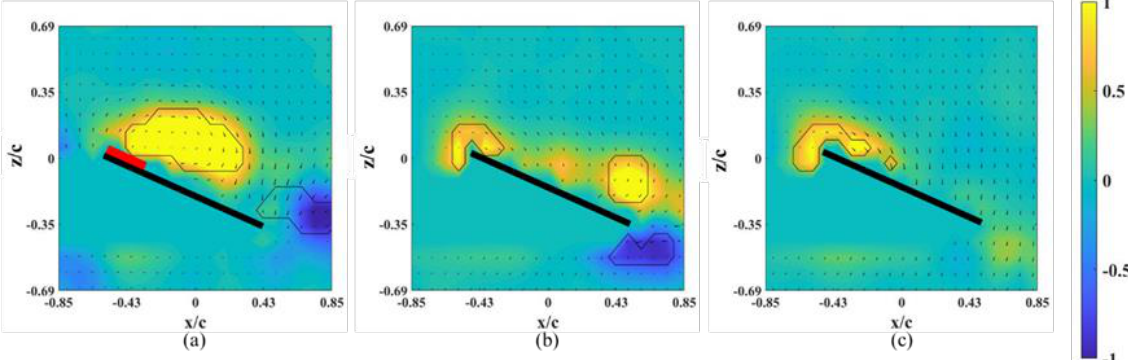
Figure 7. Vorticity contours around the wing model with an alula-VG placed at L w * = 0.25 ( r* = 0.37) and α = 25 ◦ . ( a ) r* = 0.36, ( b ) r* = 0.46, and ( c ) r* = 0.56.